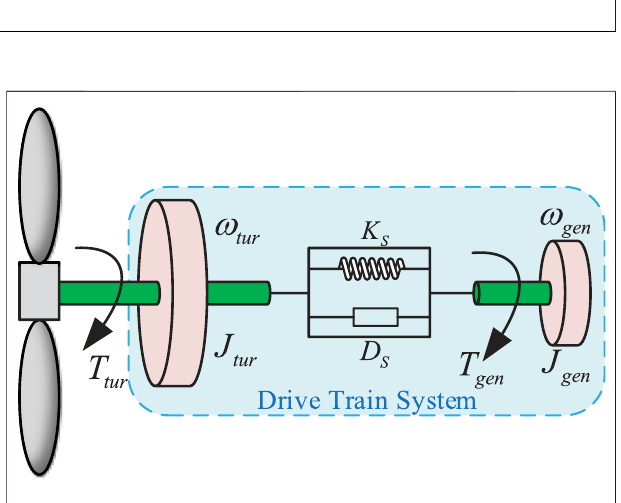
FIGURE 3 | Block diagram of PMSG.